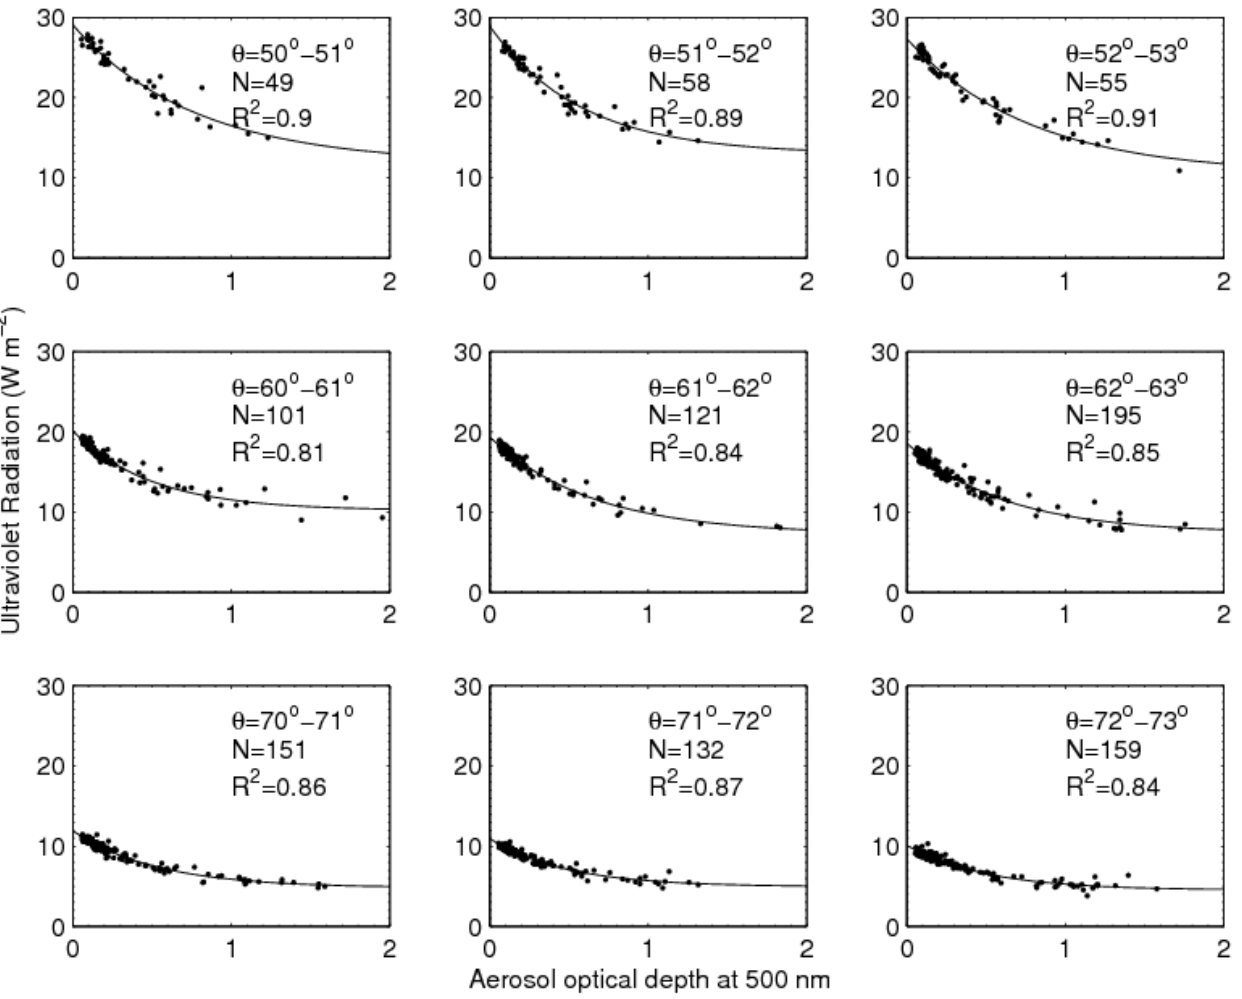
Fig. 3. The dependence of UV radiation on aerosol optical depth at 500nm for nine solar zenith angles. The line represents the fitting results of the data using an exponential equation.